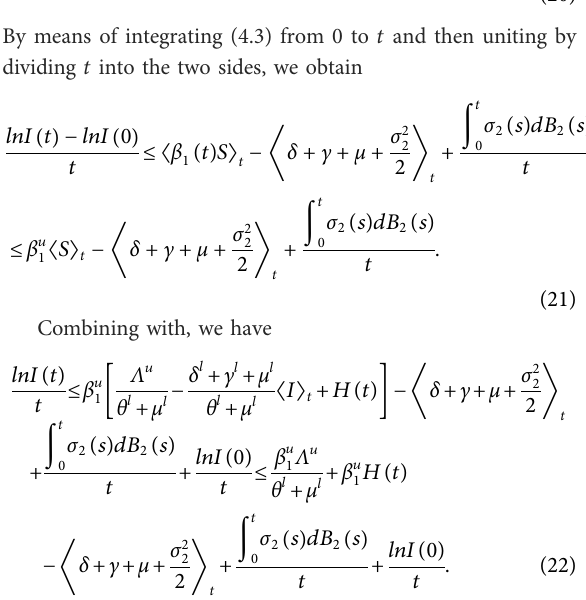
FIGURE 4 Path simulations of I(t) for the stochastic model with β 2 ( 1 ) (cid:2) 0 . 1 , β 2 ( 2 ) (cid:2) 5 , β 2 ( 3 ) (cid:2) 10 , σ i (cid:2) 0 . 06 , i (cid:2) 1 , 2 , 3 , 4.